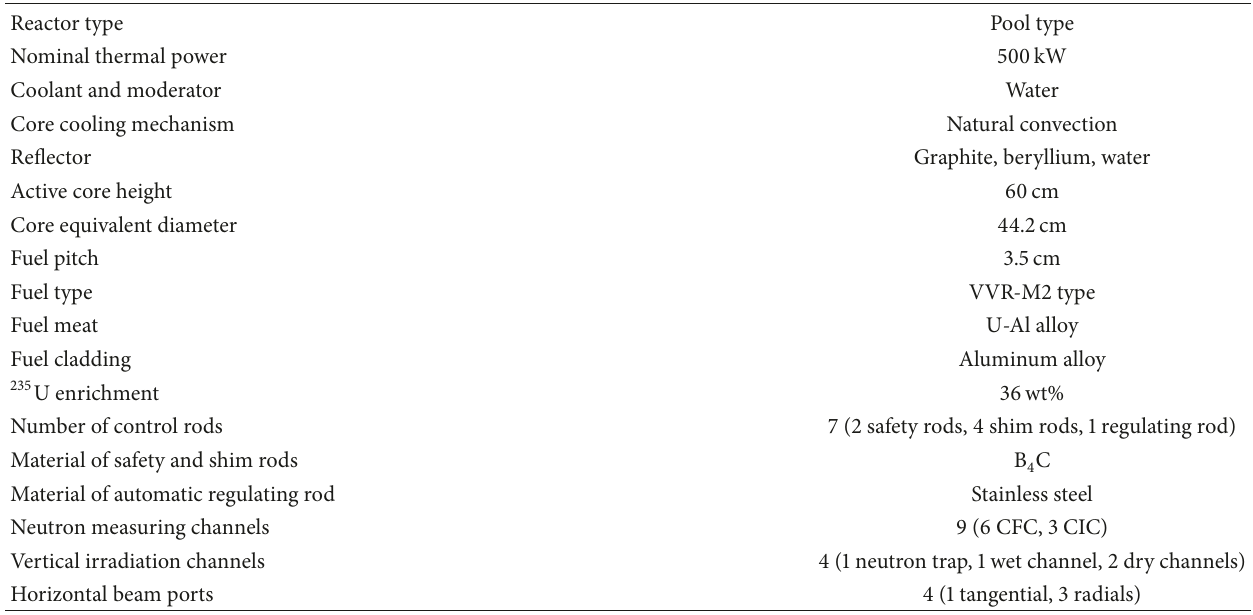
Figure 3: Horizontal cross sections of (a) the VVR-M2 fuel bundle and (b) the fuel lattice cell model in the PIJ code. Table 1: Specifications of the